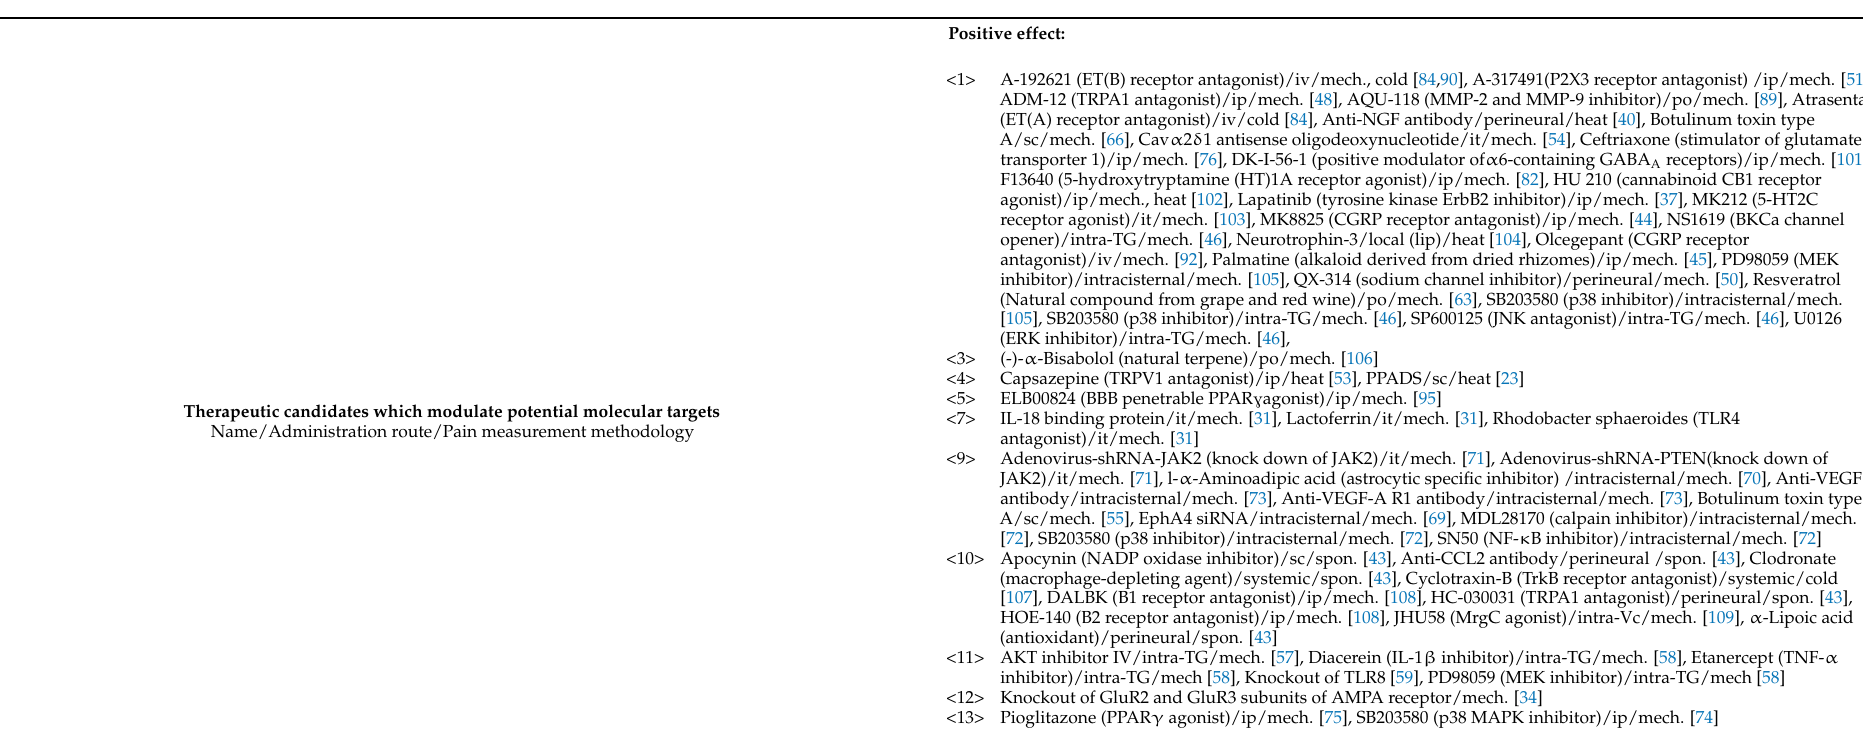
Therapeutic candidates which modulate potential molecular targets Name/Administration route/Pain measurement methodology